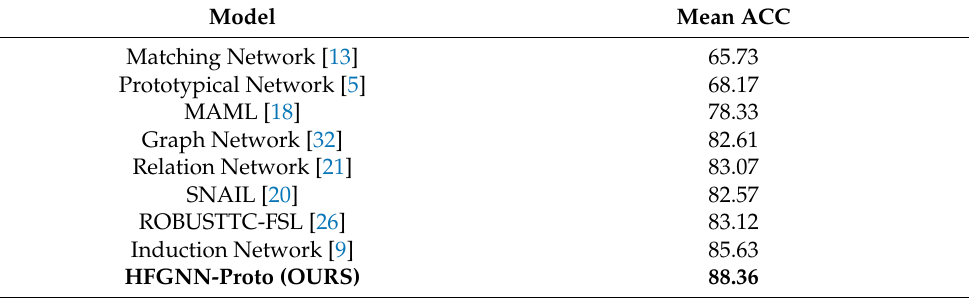
Table 3. Comparison of the average classification accuracy (%) on